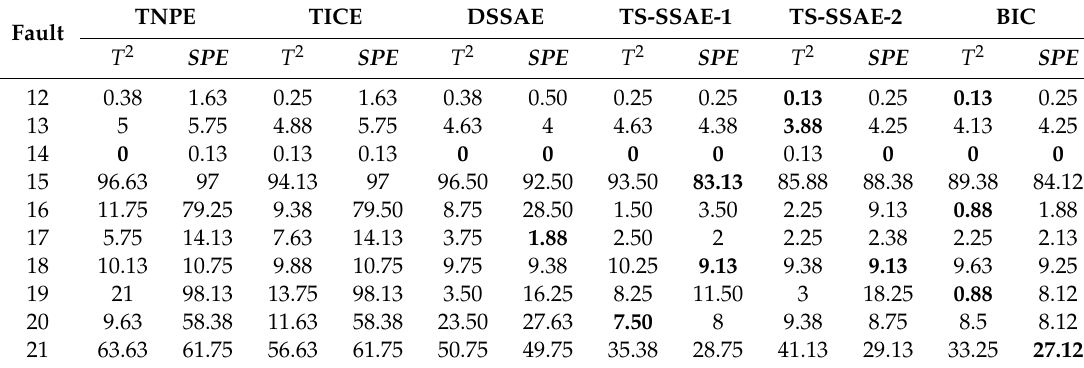
( f ) BIC Figure 8. Monitoring results of the Tennessee-Eastman process for fault 10. By the detection results of the TE process, it can be found that TICE is slightly better than the TNPE algorithm in overall detection, indicating that the idea of considering time constraints in the spatial neighborhood is conducive to the algorithm to extract more effective features. The conclusion that the detection effect of the TNPE algorithm is significantly better than that of the NPE and PCA algorithms also indicates that considering the dynamic correlations between data is an essential factor in improving the performance of process monitoring [7]. Compared with the above four algorithms, TS-SSAE shows the optimal detection capability in TE process, and the comparison with DSSAE algorithm shows that it has more advantages by using neighborhood information to combine the current samples for dealing with industrial process dynamic problems. Compared with the algorithm